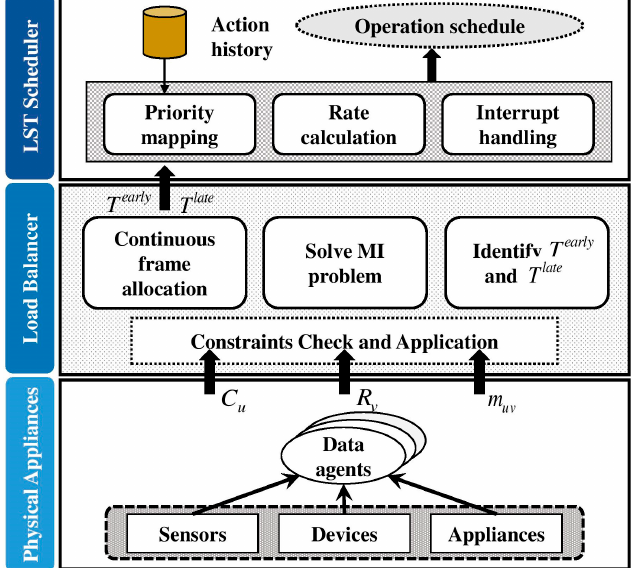
Figure 4. Overview of the proposed load balancing scheme and least slack time (LST)-based scheduling scheme for energy management.